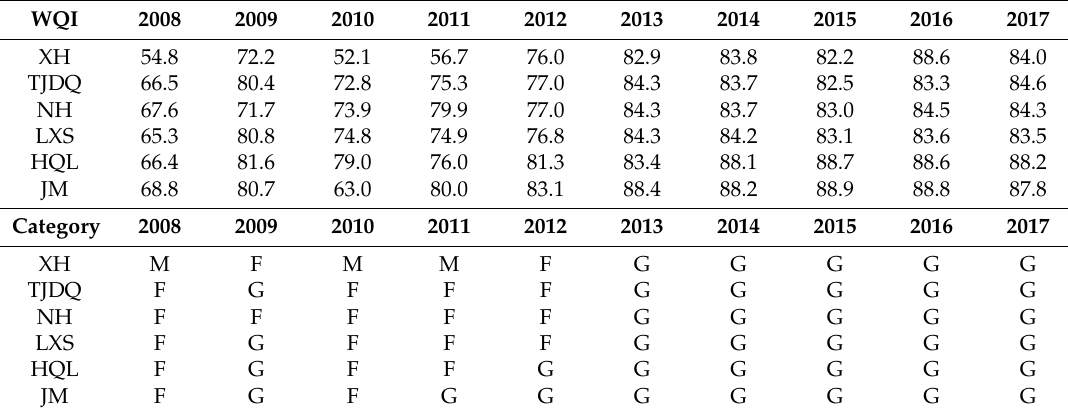
Table 4. The water quality index and category from six sites from 2008 to 2017 created with the use of the Canadian Council of Ministers of the Environment Water Quality Index (CCME-WQI)